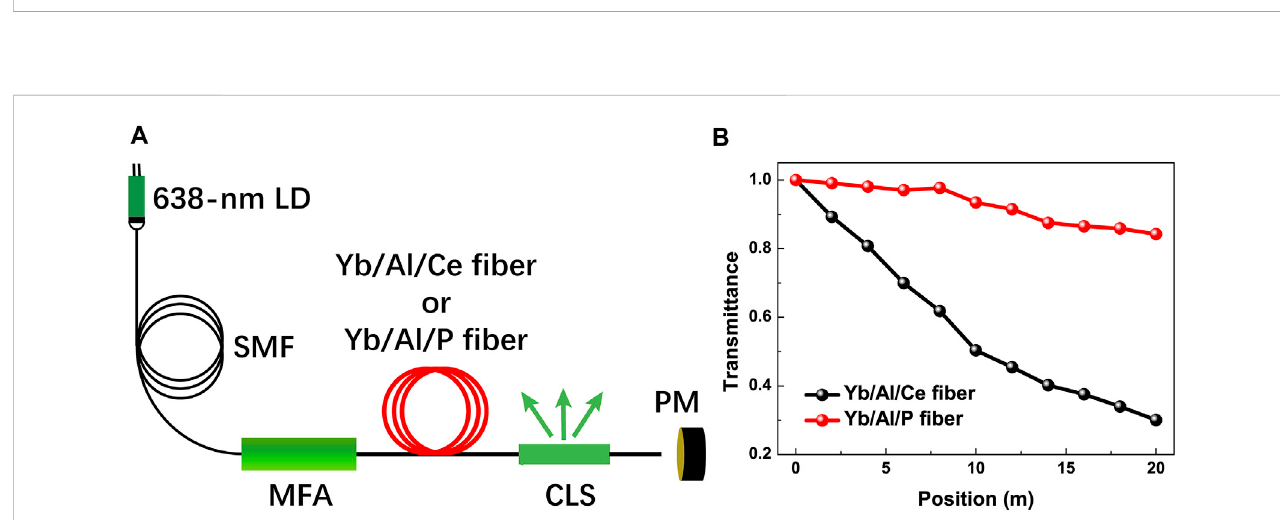
FIGURE 10 (A) Schematic diagram of the experimental setup for 638 nm transmittance measurement; (B) the measured results of the 638 nm transmittance of Yb/ Al/Ce and Yb/Al/P co-doped fi